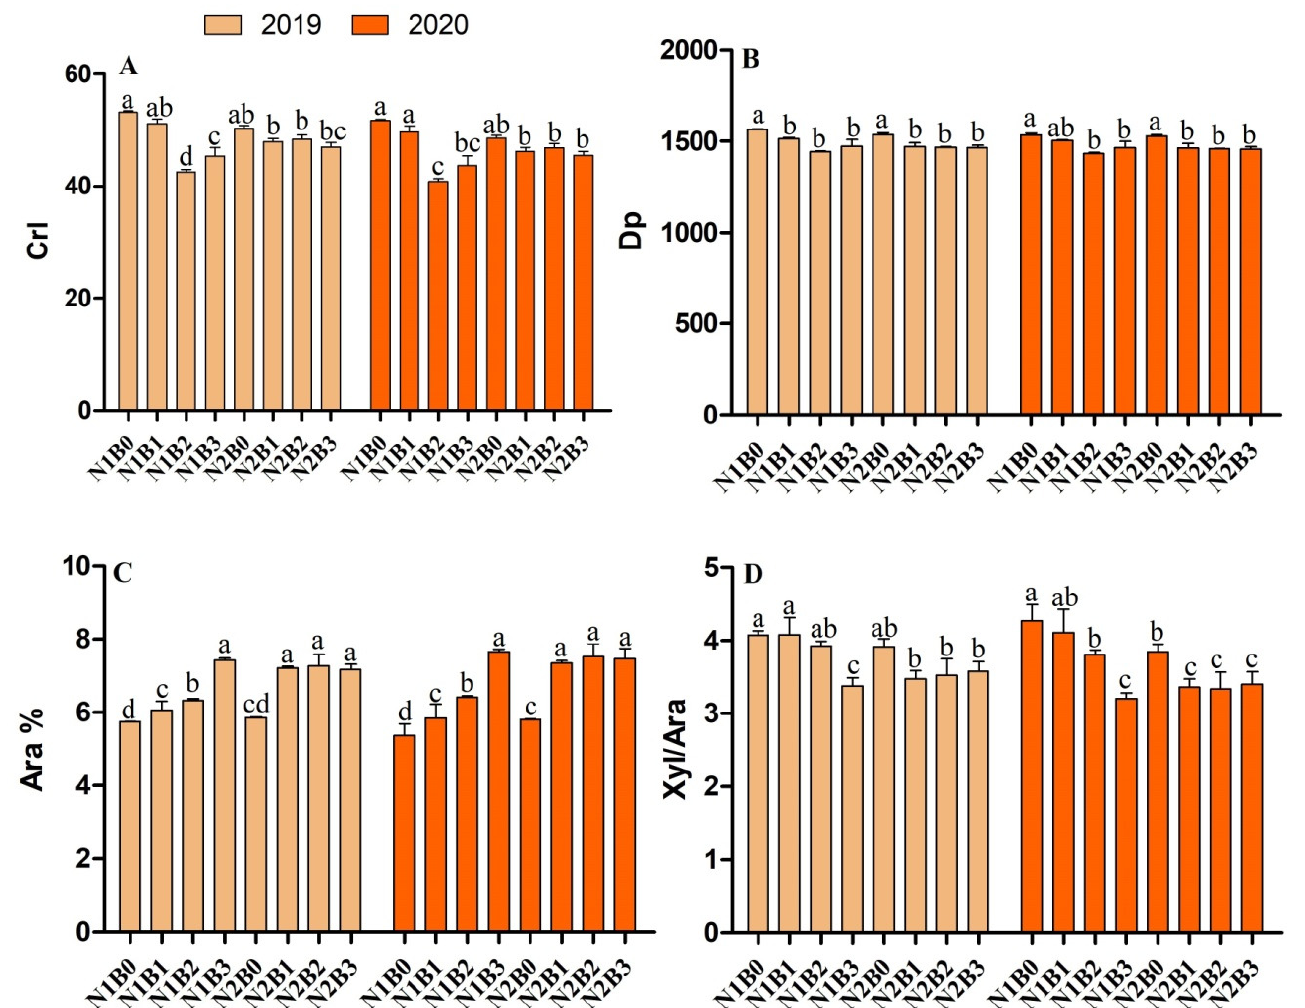
Figure 4. Biochar and nitrogen fertilizer effect on cell wall polymers feature ( A ) crystalline index (CrI) of cellulose, ( B ) degree of polymerization of cellulose, ( C ) arabinose proportion of hemicellulose, ( D ) ratio of xylose and arabinose. Different letters on bars are not significantly different at p < 0.05. (n = 3).